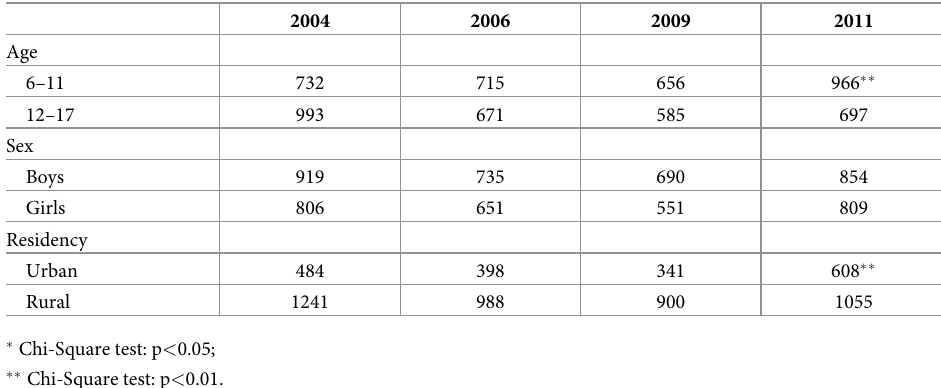
Table 1. Characteristics of participants stratified by age, sex and